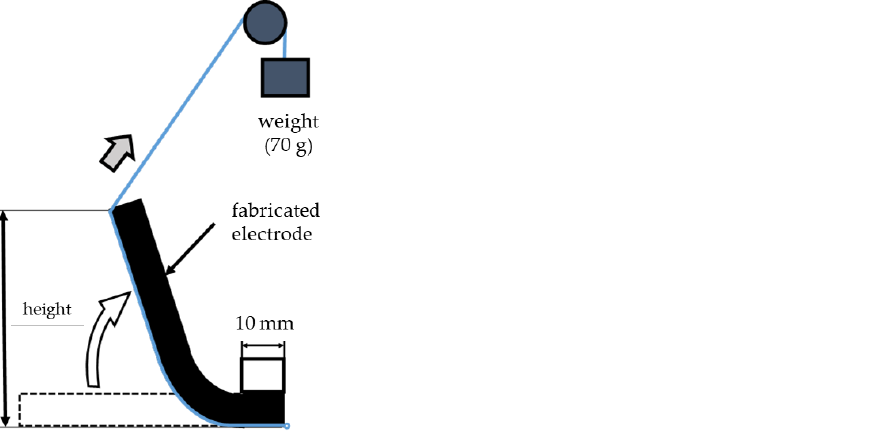
Figure 3. Schematic diagram of flexibility measurements (redrawn from Hatakeyama et al.,